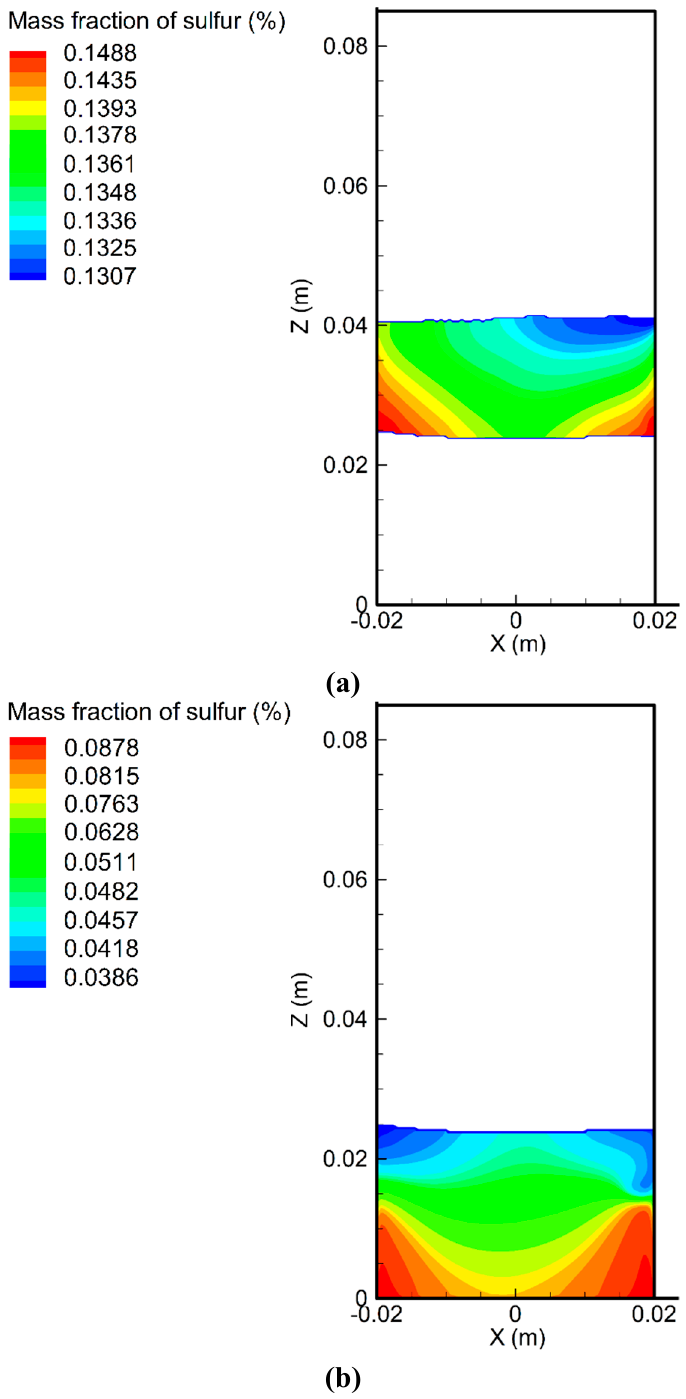
Figure 8. Distribution of the sulfur mass fraction at 600 s with the 1873 K heating temperature ( a ) molten slag, and ( b ) molten manganese.